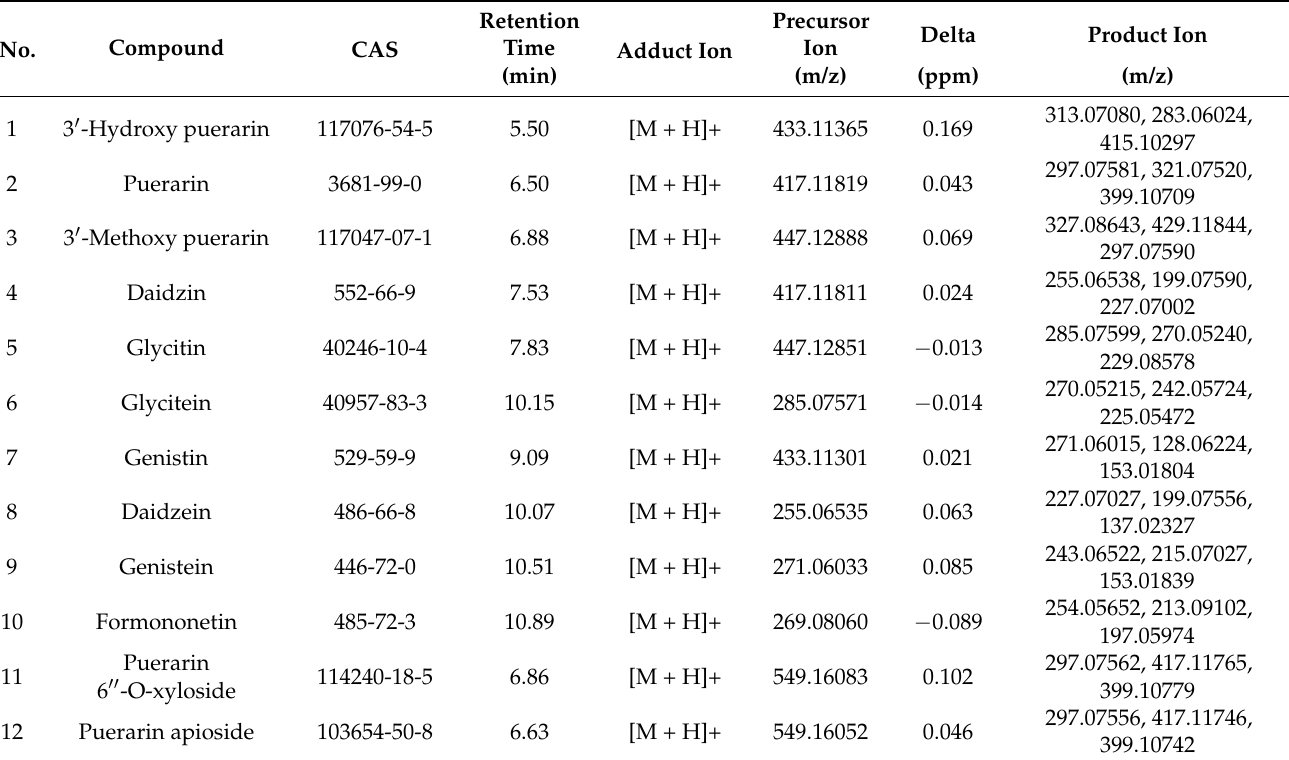
Table 1. The detailed MS parameters of 12